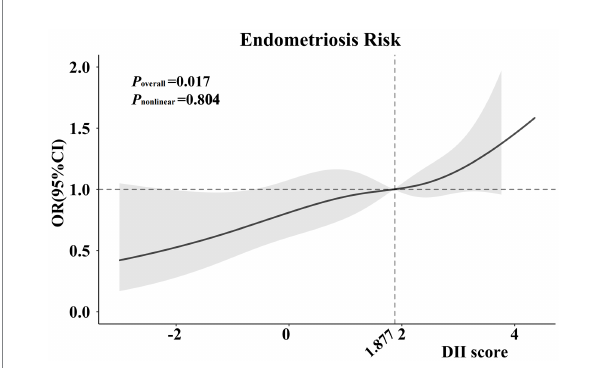
FIGURE 2 Cubic regression spline of the endometriosis risk by DII scores among the entire population. Cubic regression spline was adjusted for age, ethnicity, education level, obesity, drinking status, smoking status, hypertension, diabetes, marital status, fertility status and use of oral contraceptives. ORs are indicated by solid lines and 95% CIs are presented by shaded areas. DII, dietary inflammatory index; OR, odds ratio; CI, confidence